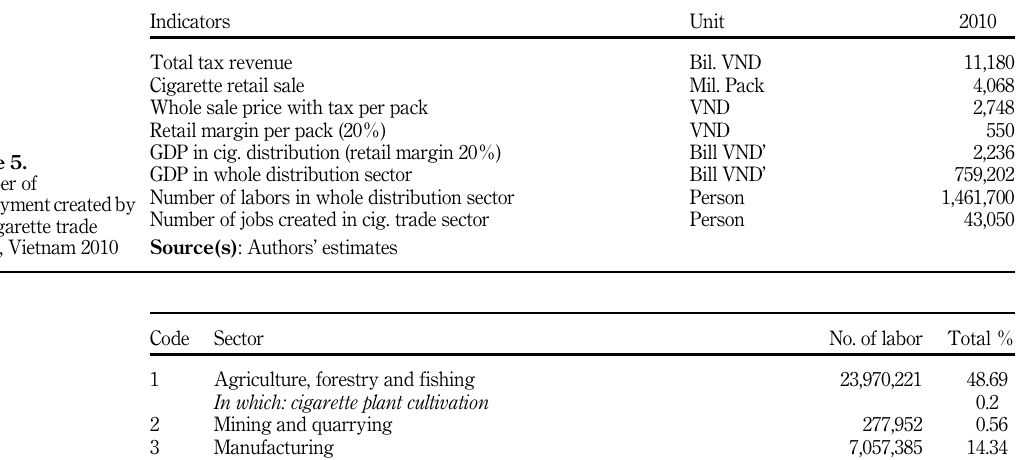
employmentcreatedby the cigarette trade sector, Vietnam 2010